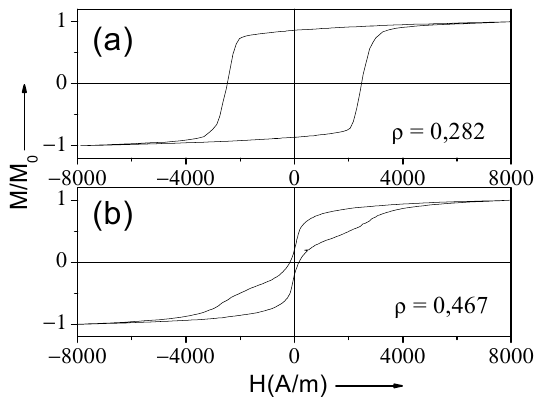
Figure 24. Hysteresis loops of Fe 71,8 Cu 1 Nb 3,1 Si 15 B 9,1 microwires with ρ = 0,282 ( a ) and ρ = 0,467 ( b ) annealed at 700 °C. Adapted from Reference [107].